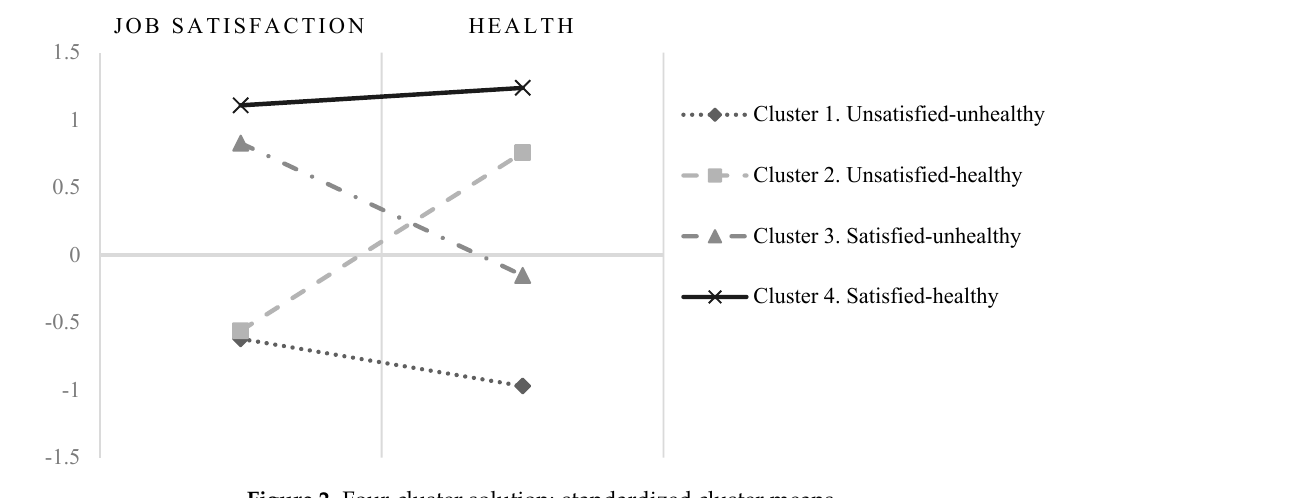
Figure 2. Four-cluster solution: standardized cluster means.